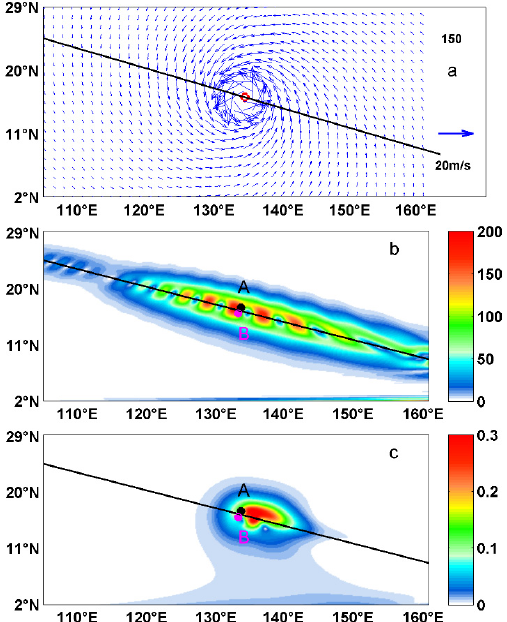
Figure 7. Distributions of ( a ) the wind field (unit in m / s) of the idealized typhoon at t = 150 h, ( b ) corresponding NIWS (unit in 10 − 3 N / m 2 ), and ( c ) oceanic near-inertial currents (unit in m / s). The black line denotes the typhoon track. The red circle in (a) denotes the typhoon center. The black dot A in (b) and the magenta dot B in (c) are opposite locations on the two sides of the typhoon track. To validate the model, a point (16°85 ′ N, 133.7° E) on the right side of the idealized typhoon (the black dot A shown in Figure 7b,c), which is about 80 km away from the typhoon track, was chosen to represent the meteorological observation station. The simulated wind speed at this location and the corresponding mixed layer near ‐ inertial currents simulated from the slab model were compared with the observational data (16°83 ′ N, 112°33 ′ E) and the CFSR data (16°25 ′ N, 112°75 ′ E), respectively (Figure 8). It shows that the SLOSH model results basically match the observations.